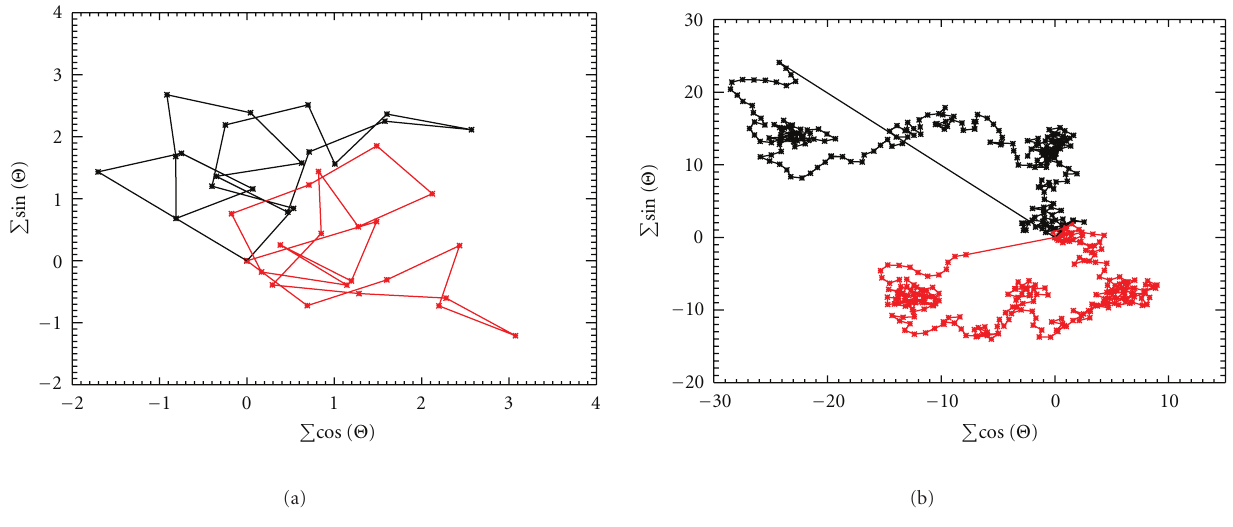
Figure 12: (a) The parameter r − ( l ) (the black dots) for odd multipoles and r + ( l ) (the red dots) for even ones in Galactic coordinates. The mean angles are estimated from the first 40 multipoles. (b) the same as the (a), but for ecliptic coordinates.